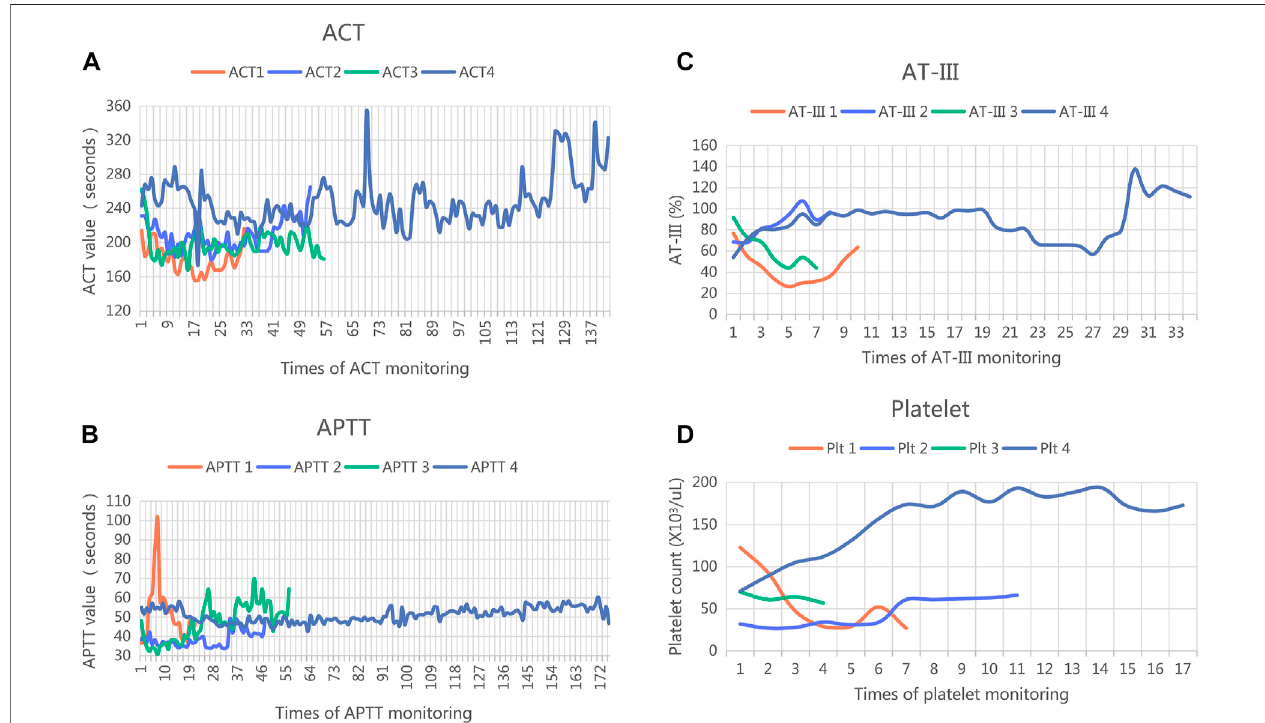
FIGURE 2 | Monitoring of ACT, APTT, AT-III and platelet in anticoagulant therapy. ACT, activated clotting time; UFH, unfractionated heparin; APTT, active partial thromboplastintime;AT-III,anti-thrombinIII; (A) ACT1(orangeline)showedACTlevelduringday1today3(UHFtherapy);ACT2(blueline)showedACTlevelduringday 3today8(argatrobantherapy);ACT3(greenline)showedACTlevelduringday8today12(UHFtherapy);ACT4(darkblueline)showedACTlevelduringday12today 27(argatrobantherapy); (B) APTT1(orangeline)showedAPTTlevelduringday1today3(UHFtherapy);APTT2(blueline)showedAPTTlevelduringday3today8 (argatroban therapy); APTT 3 (green line) showed APTT level during day 8 to day 12 ( UHF therapy); APTT 4 (dark blue line) showed APTT level during day 12 to day 27 (argatroban therapy); (C) AT-III 1 (orange line) showed AT-III level during day 1 to day 3 (UHF therapy); AT-III 2 (blue line) showed AT-III level during day 3 to day 8 (argatroban therapy); AT-III 3 (green line) showed AT-III level during day 8 to day 12 ( UHF therapy); AT-III 4 (dark blue line) showed AT-III level during day 12 to day 27(argatrobantherapy); (D) platelet1(orangeline)showedplateletlevelduringday1today3(UHFtherapy);platelet2(blueline)showedplateletlevelduringday3today 8 (argatroban therapy); platelet 3 (green line) showed platelet level during day 8 to day 12 ( UHF therapy); platelet 4 (dark blue line) showed platelet level during day 12 to day 27 (argatroban therapy).